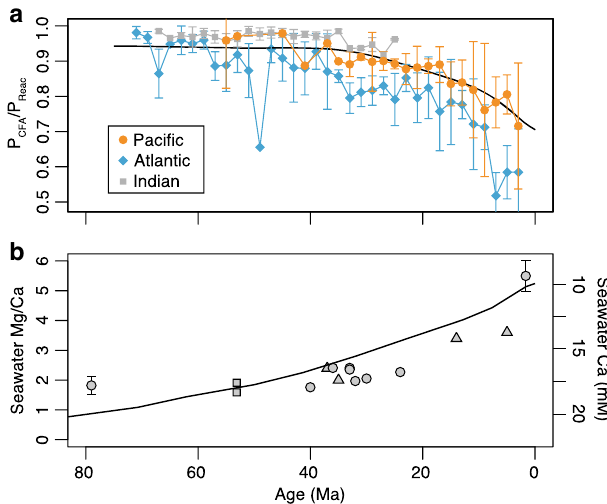
Fig. 4 Coupling of CFA burial and calcium over 80 million years. a Changes in the burial ratio of CFA-associated P to total reactive P (a sum of organic P, CFA, and iron-bound P) in deep-sea sediments. Points represent mean values for each 2 myr bin, with the error bars represent one standard deviation (1 σ ). The black curve represents deep- sea model results from the coupled C-P-O model. See Supplementary Information for discussion of the data compilation. b Seawater Mg/Ca ratios recorded in CaCO 3 veins of oceanic crust (circles) 14 , fl uid inclusions (triangles) 12 and echinoderm ossicles (squares) 13 . The curve denotes one of the estimates for seawater Ca concentrations through this interval 12